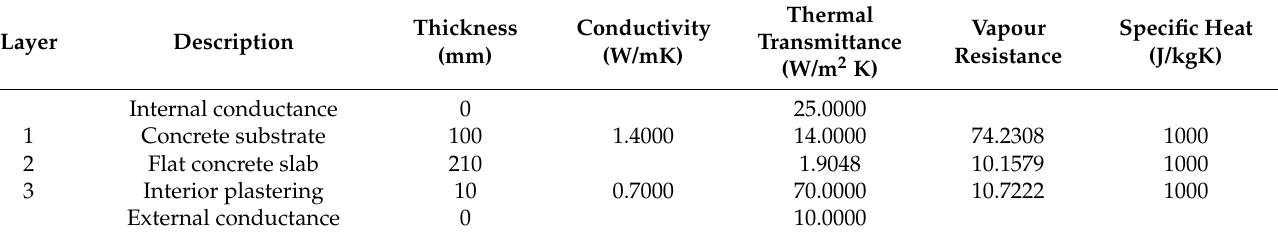
Table 4. Inter-floor and roof ceiling characteristics.